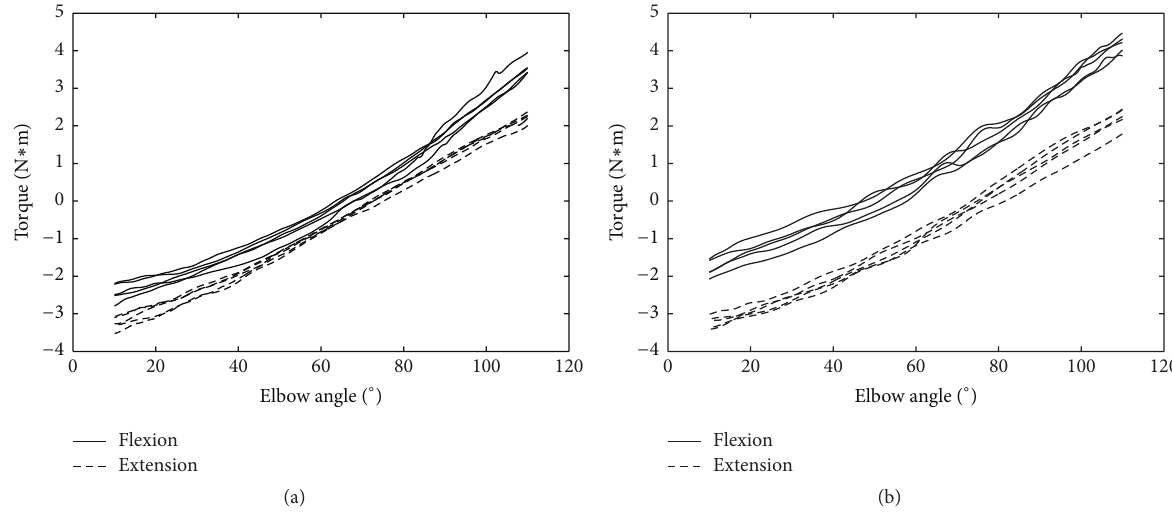
Figure 2: Angle-torque characteristics in passive flexion (solid line) and passive extension (dashed line) of left upper limb in one PD patient (UPDRS rigidity score = 3). The data included five cycles in (a) angular velocity 60 ∘ /s and (b) angular velocity 120 ∘